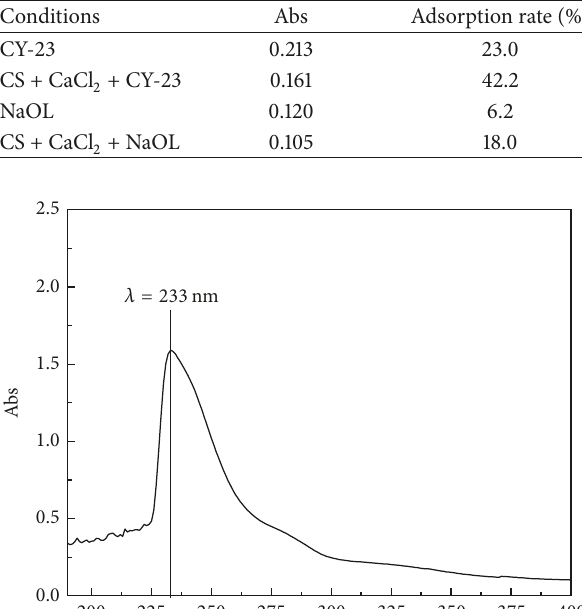
Table 3: Adsorption rate of collectors on chlorite surface at pH 10.